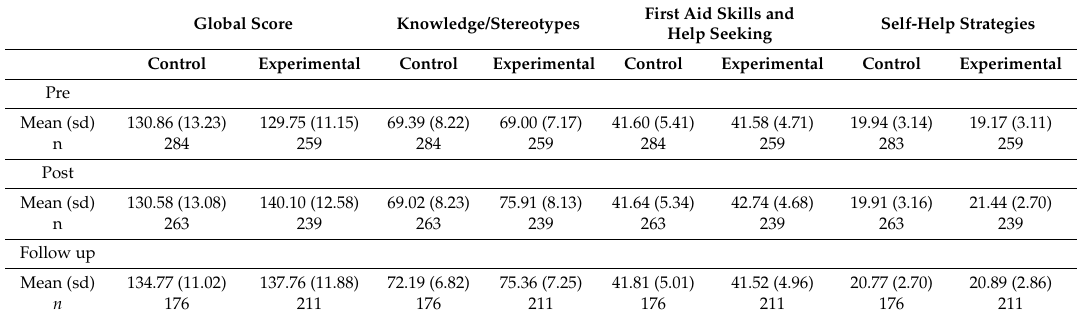
Table 2. Descriptive statistics concerning the global score and dimensions of mental health literacy at the three evaluation times—pre, post and